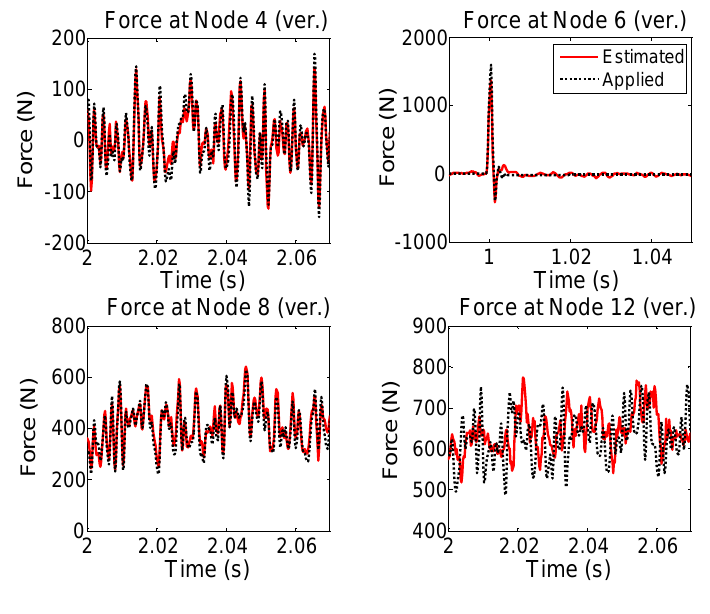
Figure 22. Same as Figure 16 but the measurement configuration is different. Sensor arrangement is shown in Figure